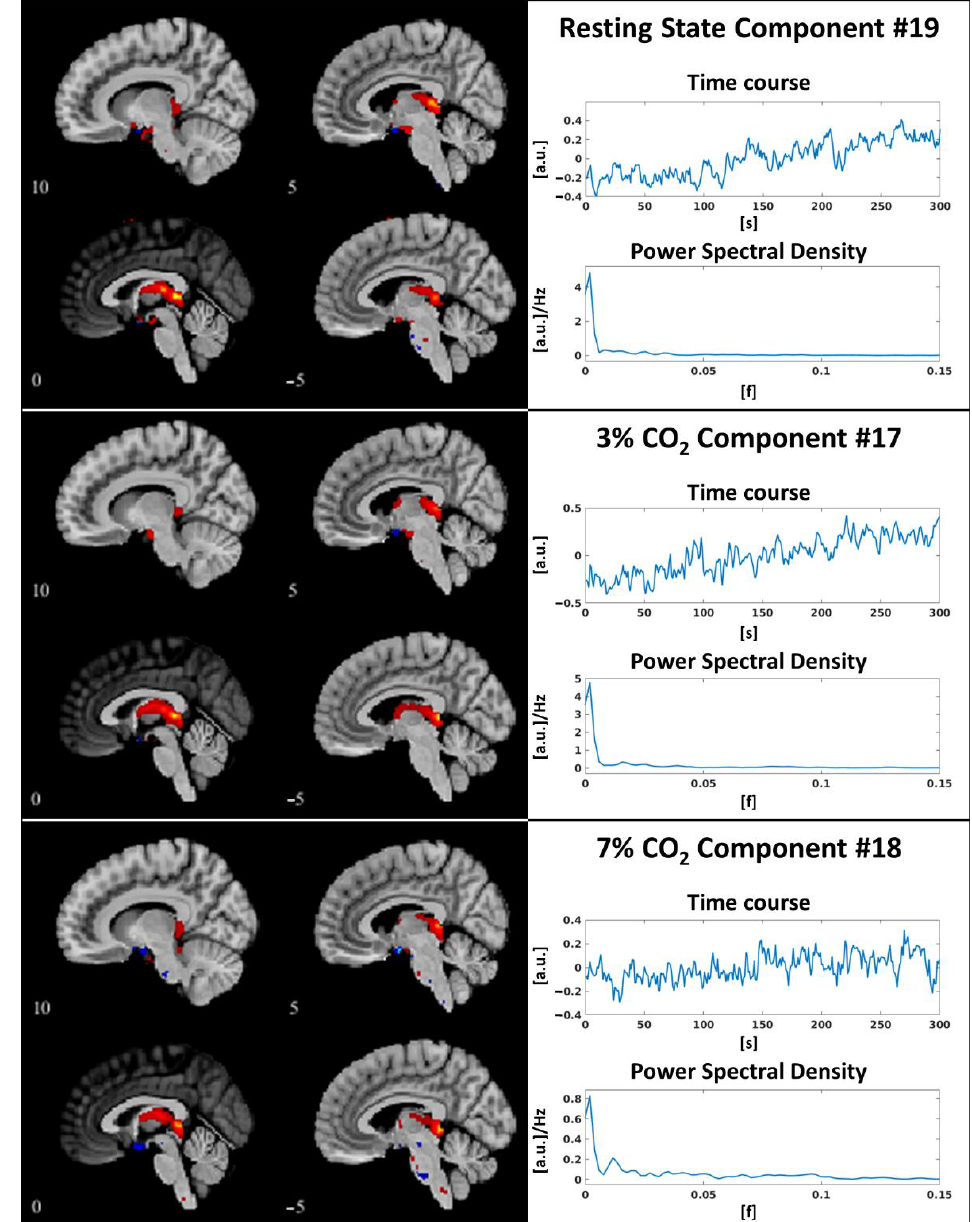
Figure 3. Triplet selected for the analysis performed using the global mask.